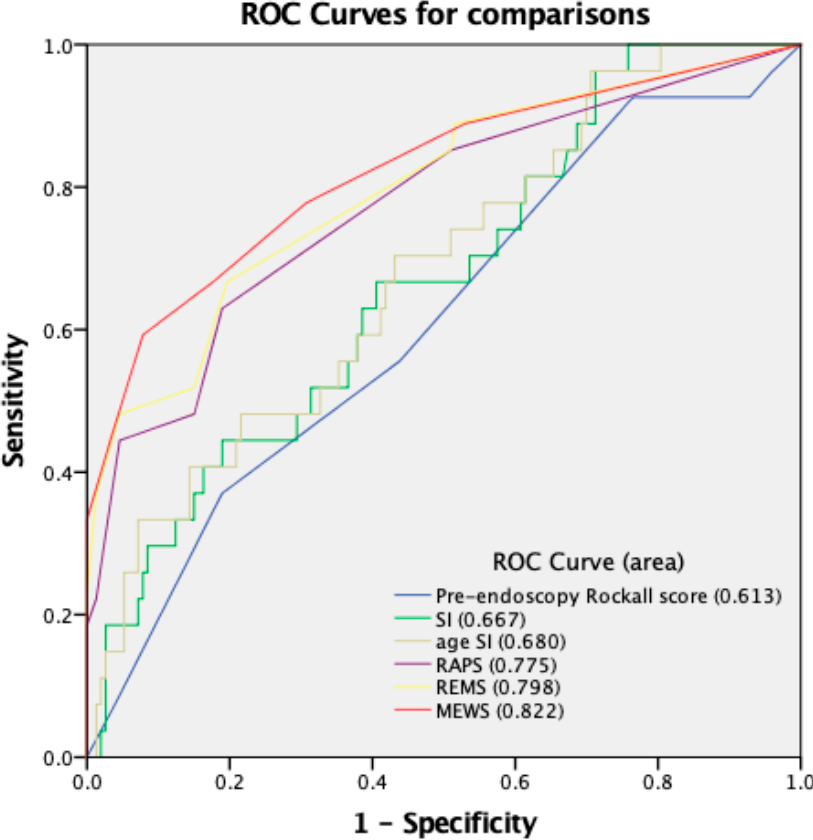
Figure 2. ROC curves for six scoring systems in evaluation of mortality for patients older than 75 years.